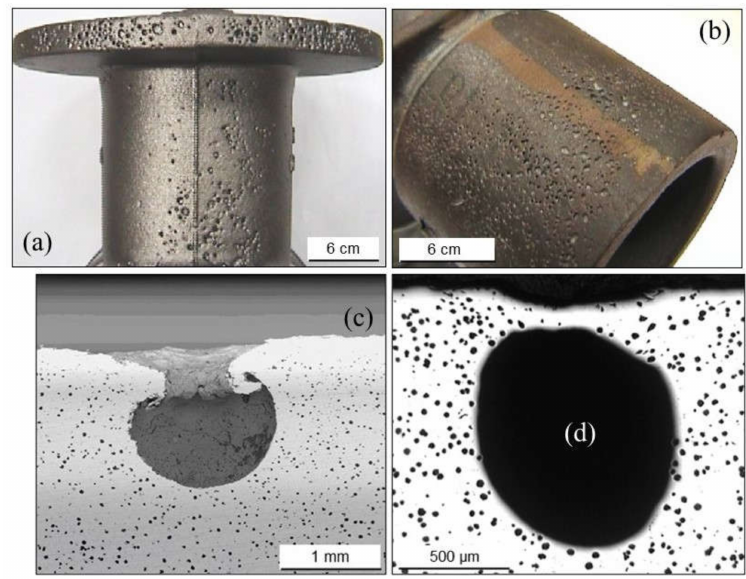
Figure 7. Pinholes found in the skin ( a ) and after machining ( b ). Deformed aspect of an open pinhole with irregular graphite and Mn-S layer in its internal surface after shot blasting ( c ). Internal pinhole close to the skin of the casting ( d